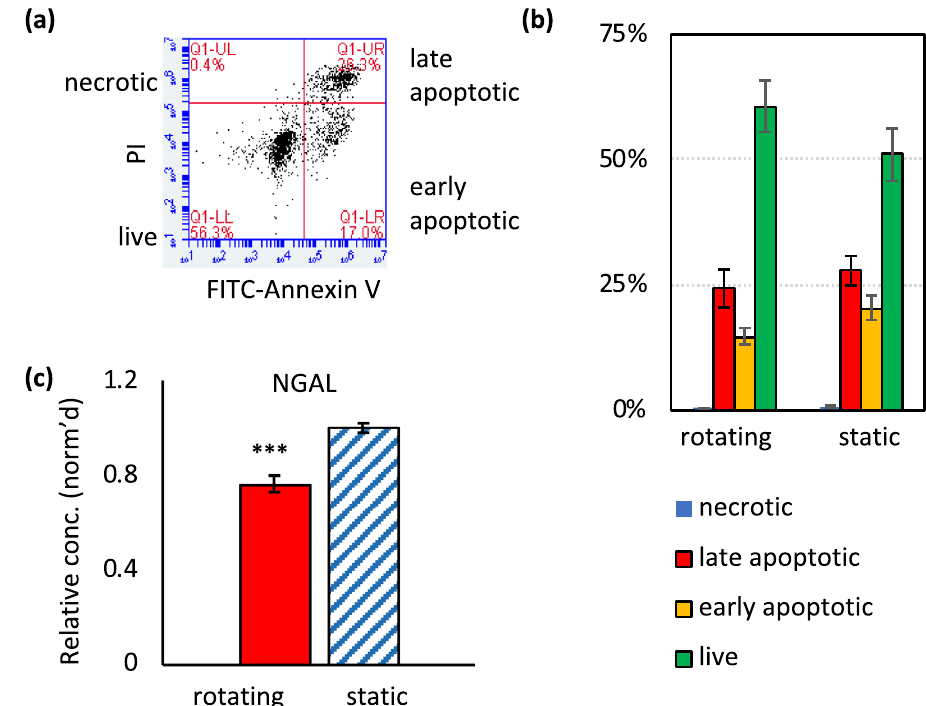
Figure 5. Effect of rotation in cell spinpods on viability of renal cells. RPTEC/TERT1 cells on Cytodex carrier beads were cultured in cell spinpods under rotating or static conditions. After 2 days, cells were trypsinized off the carrier beads, stained with propidium iodide (PI) and FITC annexin V, and analyzed by flow cytometry, panel ( a ). Necrotic cells are in the upper left quadrant (PI pos /Annexin neg ), late apoptotic cells in the upper right quadrant (PI pos /Annexin pos ), early apoptotic cells are in the lower right quadrant (PI neg /Annexin pos ), and live cells are in the lower left quadrant (PI neg /Annexin neg ). Panel ( b ) shows the proportion of cells from rotating and static cell spinpods that are necrotic, in late apoptosis, in early apoptosis, or live. Error bars indicate ± SEM of six replicates. Results are representative of four experiments. Panel ( c ) shows the relative quantity of NGAL released by RPTEC/TERT1 cells in rotating ( ) or static ( ) spin pods. NGAL data have been normalized to the average quantity of NGAL released by cells in static pods for each experiment and error bars indicate ± SEM of data pooled from five experiments. Asterisks indicate where differences in the distributions between groups were statistically significant, e.g. p < 0.05, by one-tailed Mann–Whitney U test. Rotation in a cell spinpod increased the quantity of NGAL release ( p = 1.3×e–7, w = 83; n 1 = 30, n 2 = 28) but did not induce a significant change in the quantity of PAI released ( p = 0.38, W = 425; n 1 = 30, n 2 =